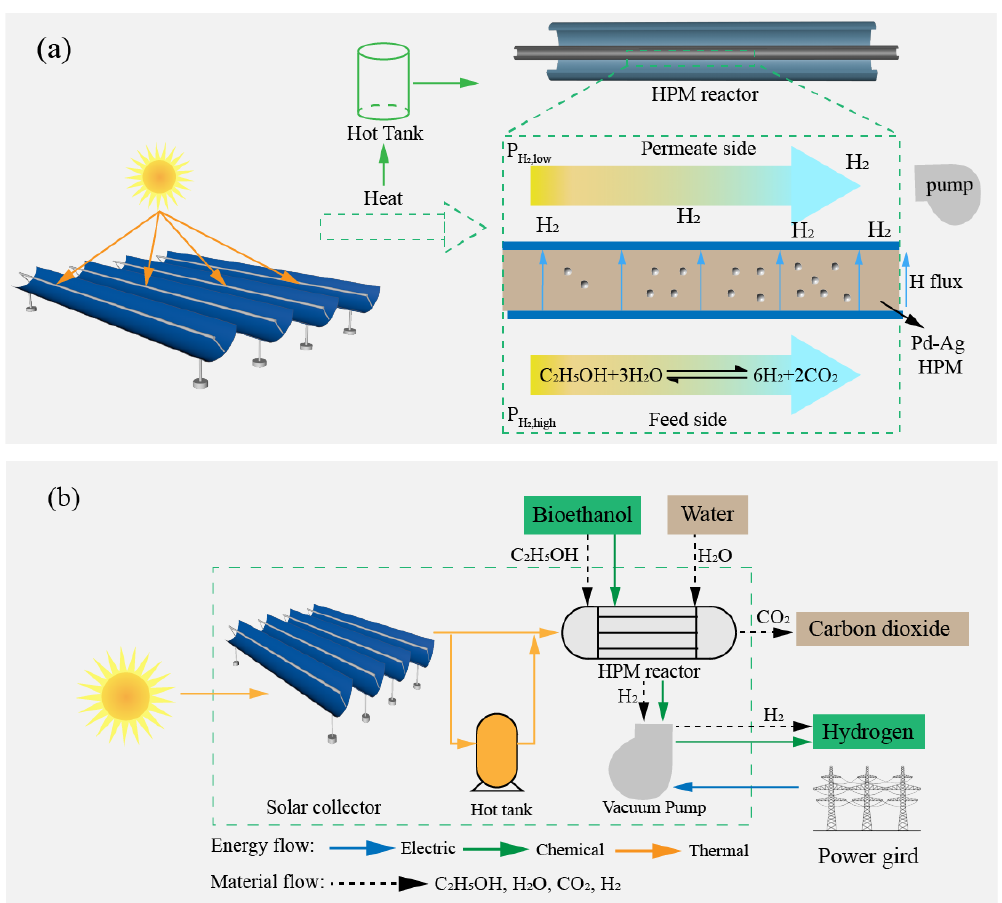
Figure 1. Conceptual schematic ( a ) and system boundary containing input/output flows ( b ) of a solar-driven ESR membrane reactor configuration